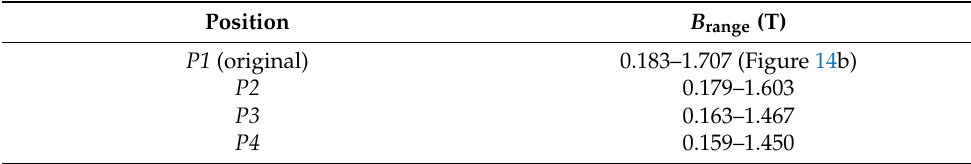
Table 4. B max for changing the vertical product positioning